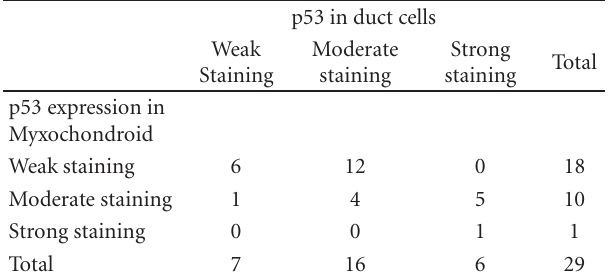
Table 8: Cross-tabulation p53 nuclear staining in myxochondroid tissue and duct cells of pleomorphic adenoma.